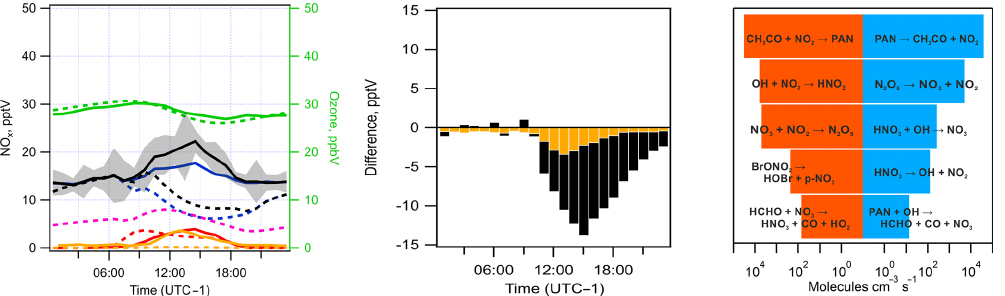
Figure 3. Left shows the measured (solid lines) and modelled (dashed) NO x and HONO diurnal behaviour at the CVO GAW station where the dominant source of NO x is a source of PAN descending from the upper troposphere having been transported from polluted regions. Shaded areas are standard error of the observations (NO x N = 153 HONO, N = 10). O 3 – green; NO x – black; NO 2 – blue; NO – red; HONO – yellow; PAN – pink. Centre is the difference between measured and modelled NO x (black) and HONO (yellow). Right shows the rates of production and loss of NO and NO 2 from sources listed in descending order of contribution over a 24h period accounting for >95% of the total.